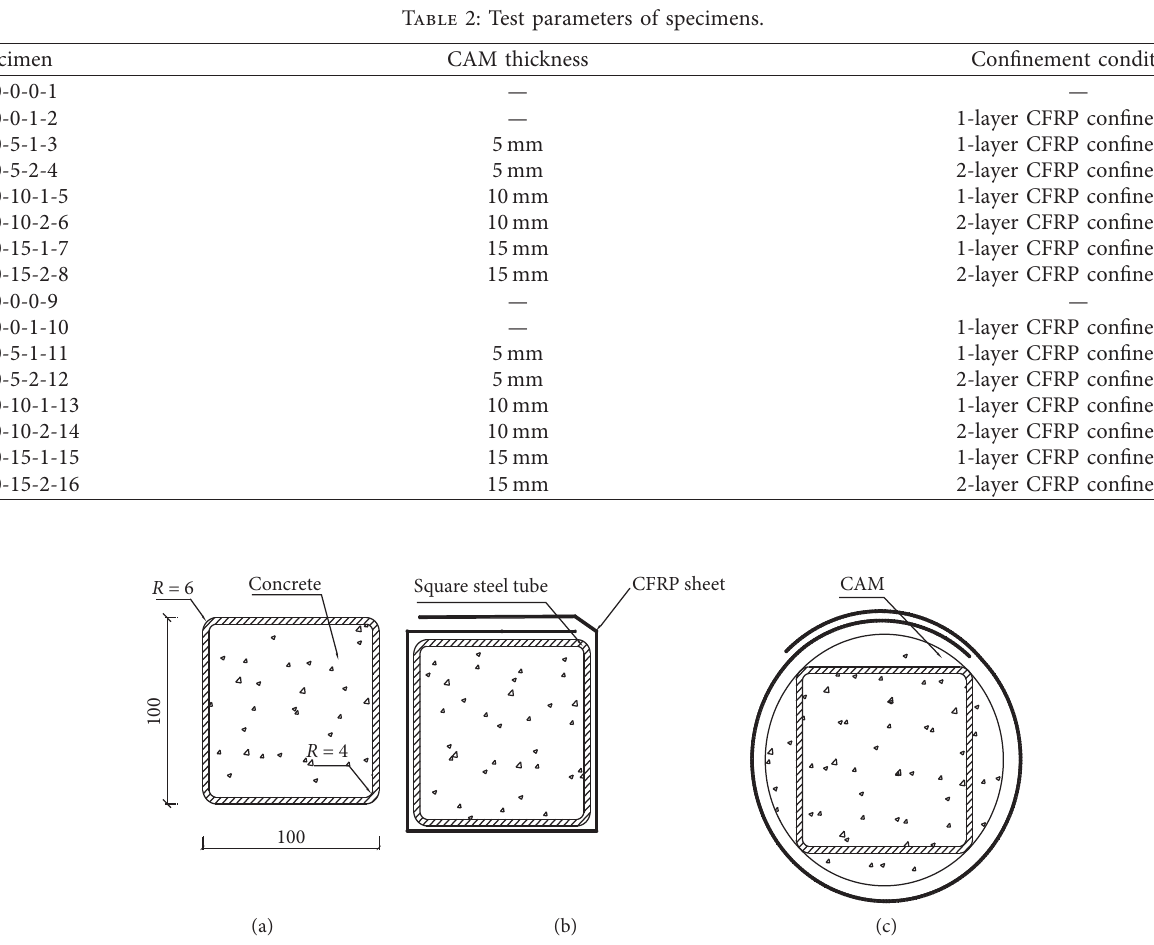
Figure 1: Cross sections of specimens. (a) CFSST column. (b) CFRP-confined CFSST column. (c) C-C-CFSST column.